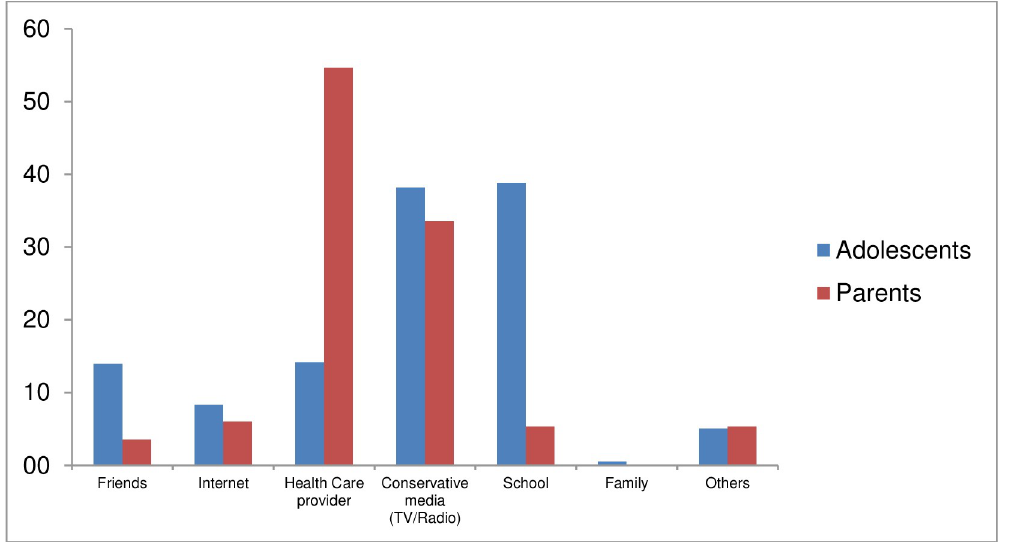
Fig 1. Main sources of information 1 for the adolescents and parents/guardians interviewed during the implementation of the HPV vaccine in 2015. 1 As multiple answers were allowed, each was considered a dichotomous variable (yes/no).